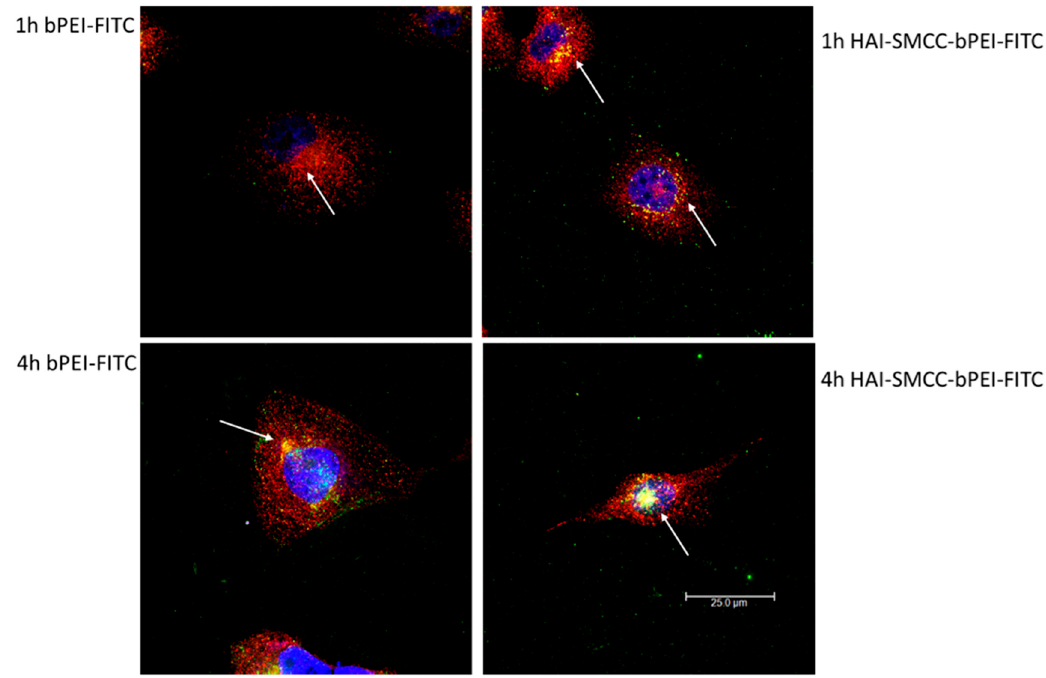
Figure 6. Co-localization of transferrin (Tf) and bPEI or HAI-SMCC-bPEI polyplexes in H1299 was imaged by the confocal microscope. H1299 cells were incubated with Tf fluorescently labeled with Texas Red (Tf-Texas Red) and bPEI or HAI-SMCC-bPEI polyplexes prepared with 50 pmol of siRNA at N/P = 5 for 1 and 4 h. The polymers were fluorescently labeled with FITC and shown in green. Tf-Texas Red was shown in red, and DRAQ5 stained nuclei were shown in blue. The arrow pointing to the yellow dots represents co-localization spots of polyplexes and Tf.